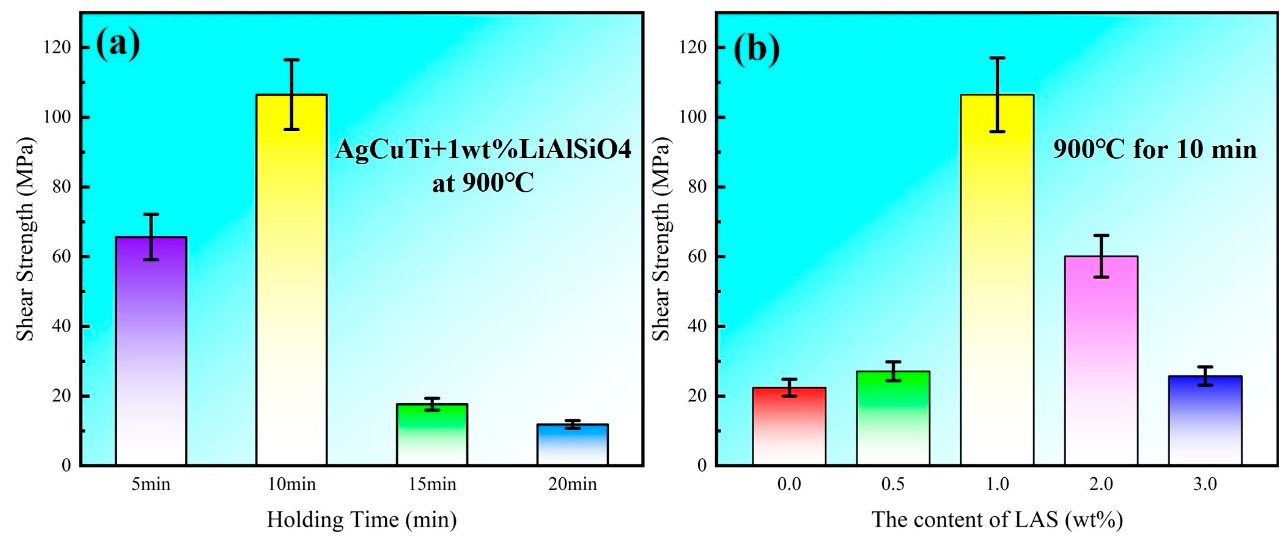
Figure 13. The effect of ( a ) holding time and ( b ) LAS content on the shear strength of SiC joints.